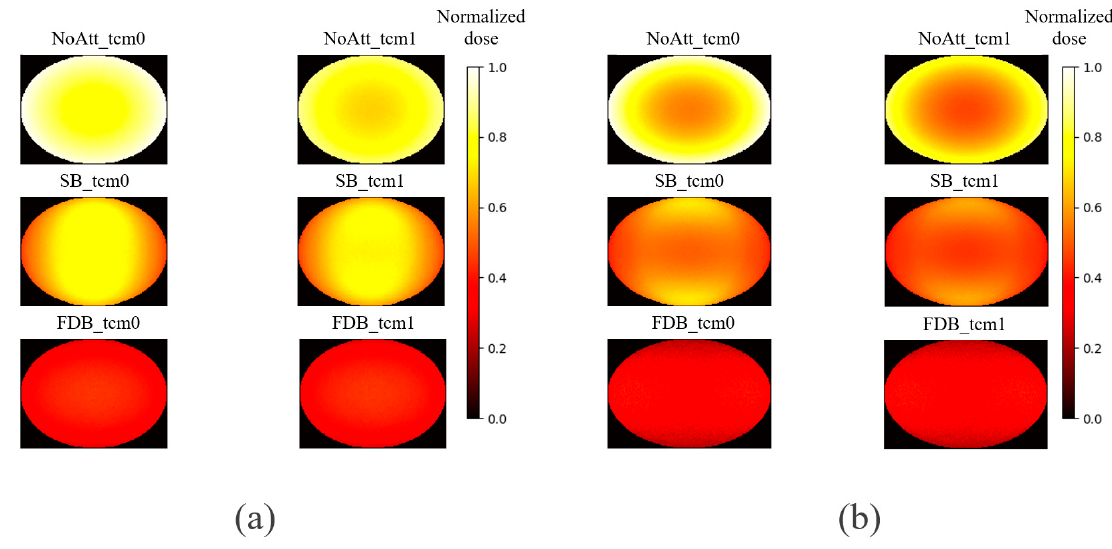
Figure 5. Dose map of ( a ) head and ( b ) body phantom using different scanning protocols. For quantitative comparison, the doses deposited in all voxels of the phantoms were extracted and averaged. Table 4 summarizes the relative average doses deposited in the head and body phantoms using the different scanning protocols. As shown in Table 4, compared to the NoAtt_tcm0, the doses received by both head and body-equivalent water